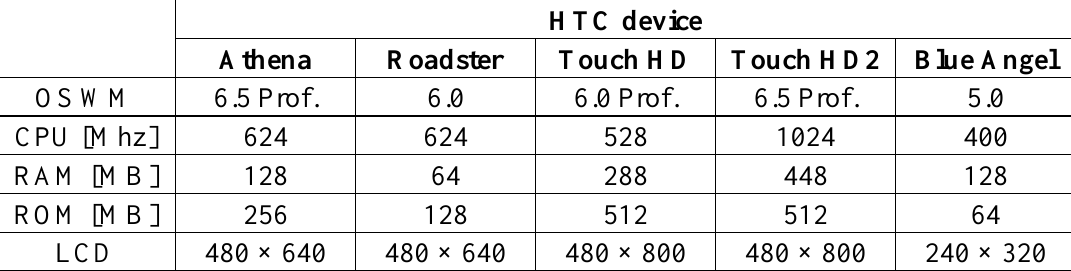
Table 3. Summary of tested device